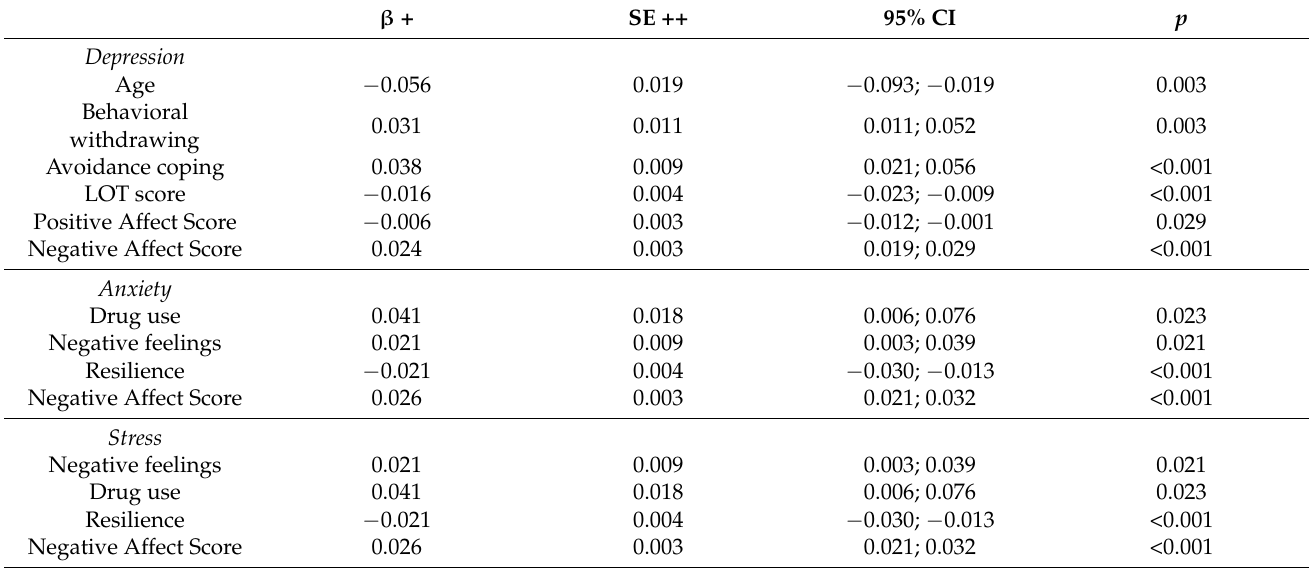
Table 7. Multiple linear regression analysis with DASS-21 as the dependent variable and students’ characteristics, BRIEFCOPE, LOT, RES and PANAS as independents, using the stepwise